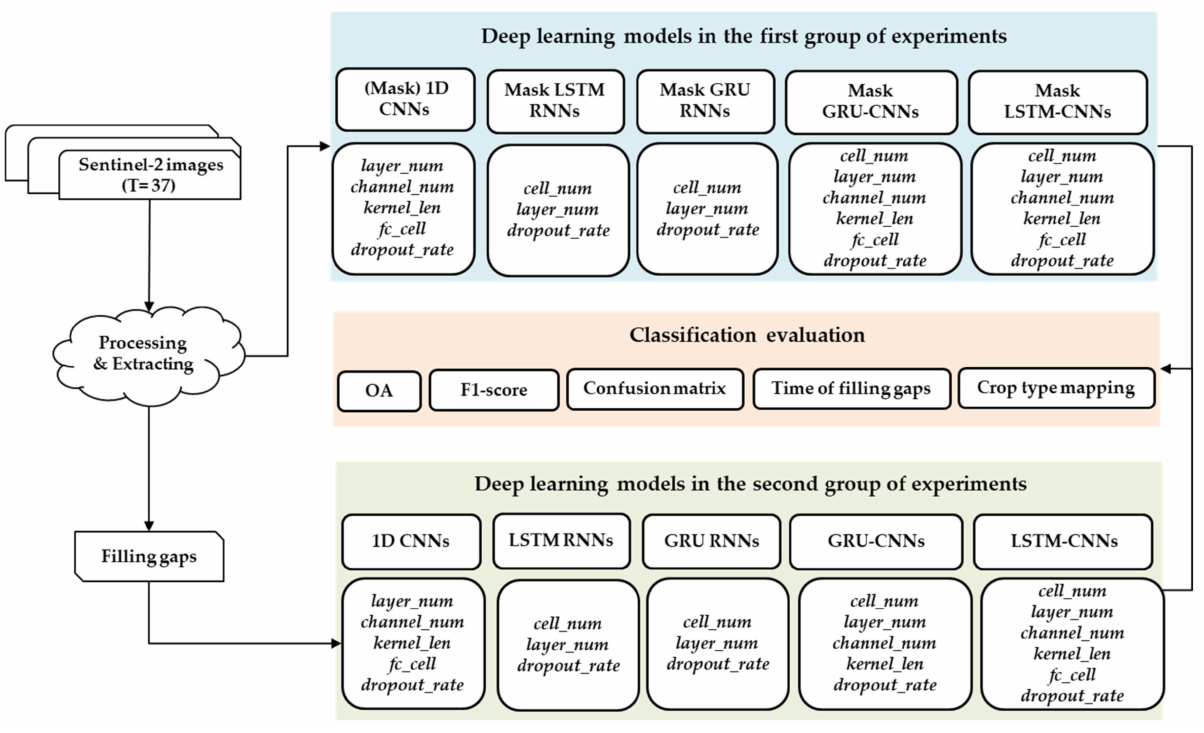
Figure 3. Experimental configurations of five deep learning models using unfilled Sentinel-2 time series data in the first group of experiments and using filled Sentinel-2 time series data in the second group of experiments. T, the length of Sentinel-2 time series data. layer_num, the number of layers; channel_num, the number of channels in a convolutional layer; kernel_len, the length of kernels in a convolution layer; fc_num, the cell number of a fully connected layer; dropout_rate, the dropout rate; cell_num, the number of LSTM or GRU units in a layer. 1D CNNs, one-dimensional convolutional neural networks; RNNs, recurrent neural networks; LSTM, long short-term memory; GRU, the gate recurrent unit; OA, overall